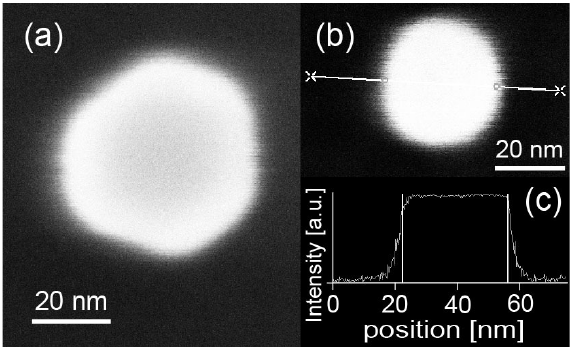
Figure 2. Scanning electron microscope topography of ( a ) a typical 50-nm GNP dispersed from the gold colloidal solution on a Si substrate before heating and ( b ) one of the same GNPs after heating at 610 ◦ C. ( c ) Line profile of the intensity of secondary electrons in ( b ). Scale bar in ( b , c ) is 20